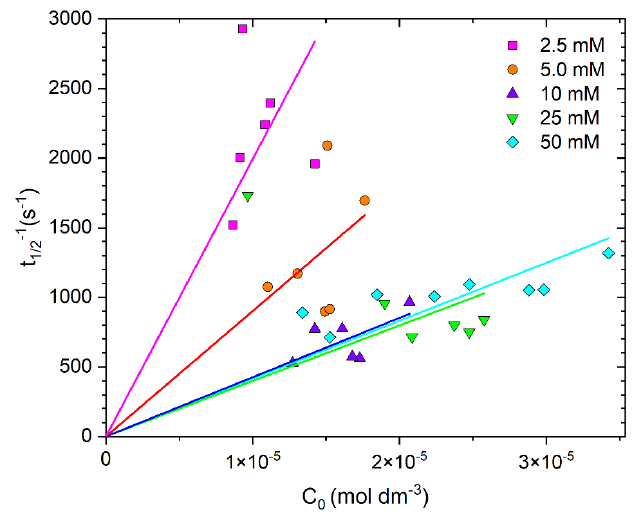
Figure 6. Kinetic analysis for decay of PAA radicals observed during pulse radiolysis of Ar-saturated aqueous solutions containing 2.5 – 50 mmol dm −3 PAA, pH 2, dose per pulse 11 – 67 Gy. Reciprocal half-life of radicals as a function of the initial radical concentration c 0 . Polymer concentrations, in mmol dm −3 of monomer units, are given in the graph.